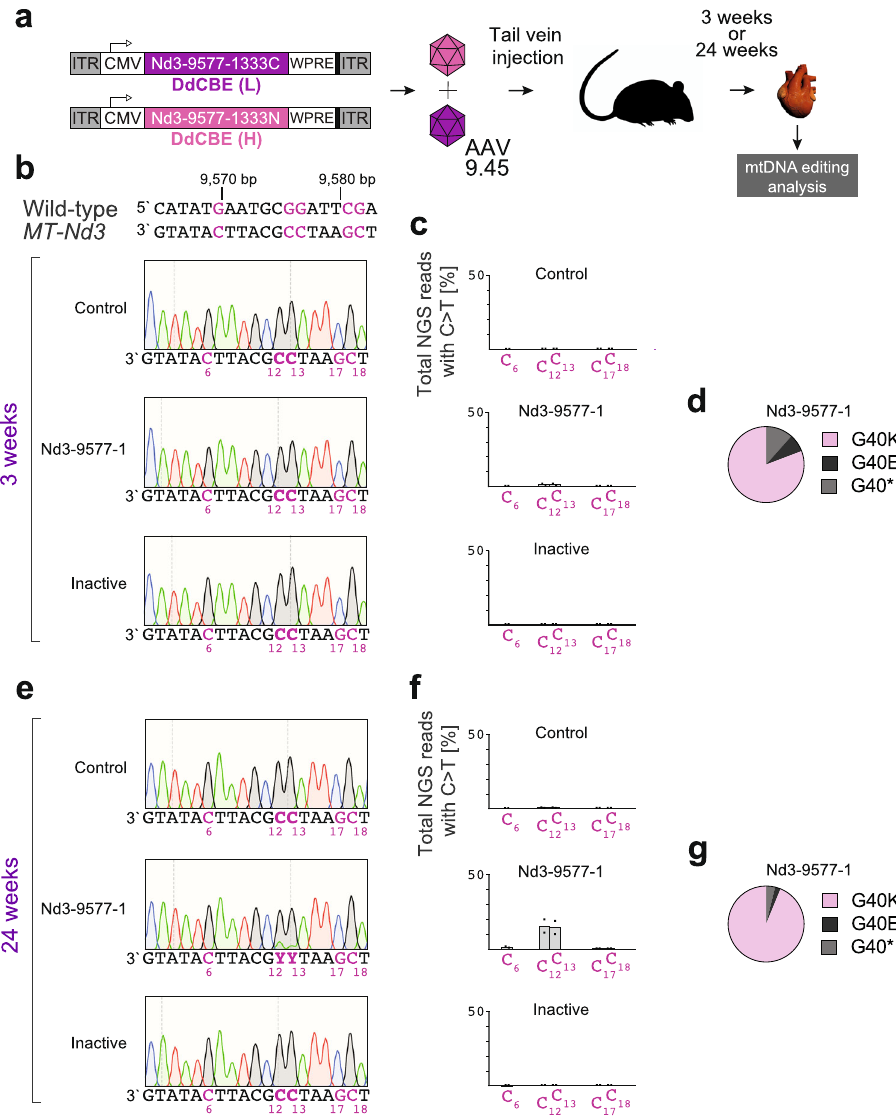
Fig. 3 Mitochondrial DNA editing in adult mouse hearts. a Scheme of in vivo experiments with adult mice. The DdCBE-Nd3-9577-1 monomers (see Fig. 2), and their catalytically inactive versions, were encoded in separate AAV genomes, encapsidated in AAV9.45 then simultaneously administered by tail-vein (TV) injection at 1 × 10 12 vg/mouse of each monomer. Animals were sacri fi ced either 3 or 24-weeks post-injection and their cardiac tissue was examined for mtDNA editing. b, e Editing of mouse MT-Nd3 with DdCBE in mouse heart at 3-weeks ( b ) or 24-weeks ( e ) post-injection, analyzed by Sanger sequencing. Potential editing sites are indicated in purple. c, f The NGS analysis of the DdCBE editing within the targeted region in adult mouse hearts at 3 weeks ( c ) or 24 weeks ( f ) after injection. Bars represent the mean ( n = 2). Source data are provided as a Source Data fi le. d, g The distribution of NGS reads containing m.9576 G (C 12 ) or m.9577G (C 13 ) edits at 3 weeks ( d ) or 24 weeks ( g ) after injection. The G40K reads contain both m.9576 G >